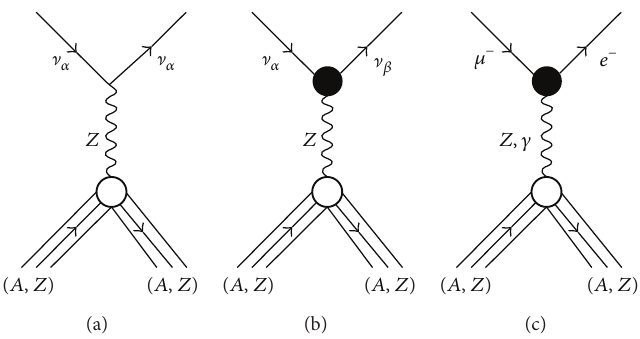
Figure1:NuclearlevelFeynmandiagramsfor(a)SM 𝑍 -exchangeneutral-current ] -nucleusreactions,(b)nonstandard 𝑍 -exchange ] -nucleus reactions, and (c) 𝑍 -exchange and photon-exchange 𝜇 − → 𝑒 − in the presence of a nucleus (muon-to-electron conversion). The nonstandard (cLFV or LFV) physics enters in the complicated vertex denoted by the bullet ∙